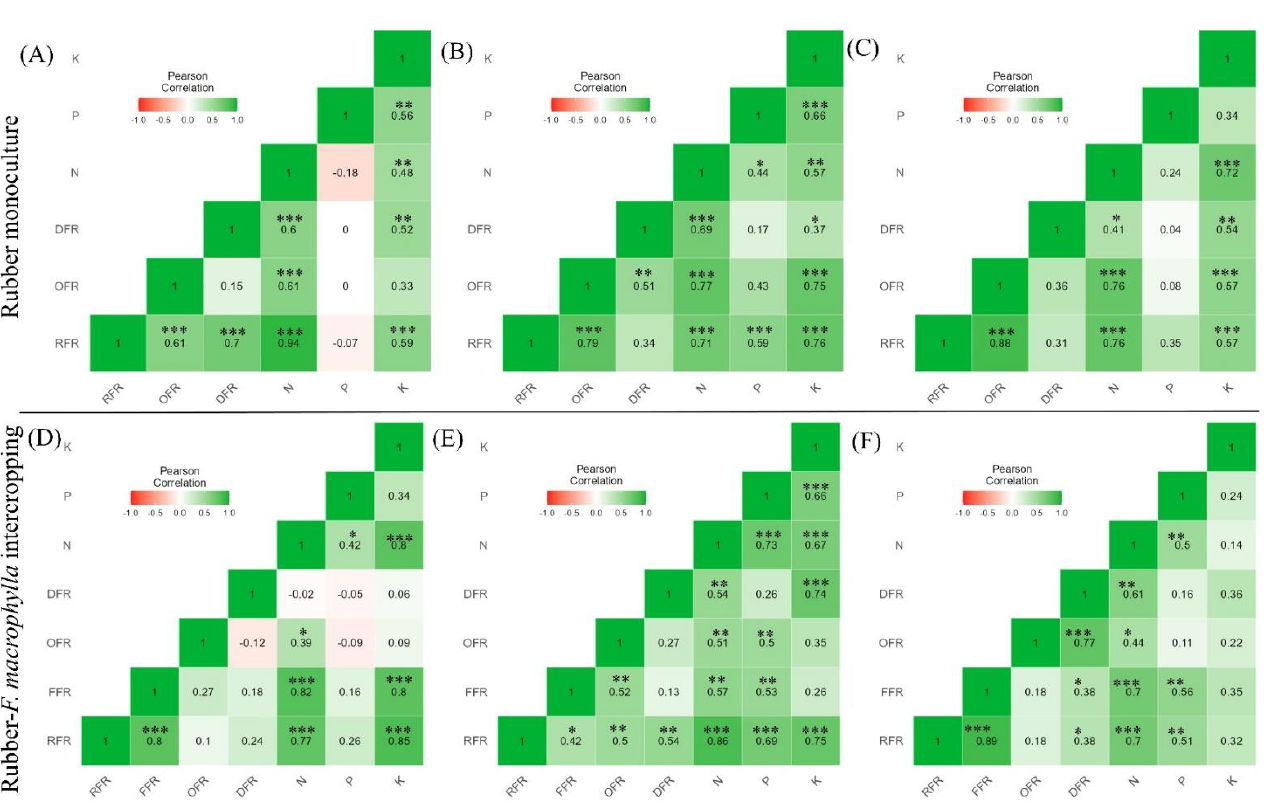
Figure 2. Correlational matrix of total fine root biomass with different species in rubber monoculture (( A ) = Correlogram of 12 years, ( B ) = Correlogram of 15 years, and ( C ) = Correlogram of 24 years) and rubber- F. macrophylla intercropping agroforestry system (( D ) = Correlogram of 12 years, ( E ) = Correlogram of 15 years, and ( F ) = Correlogram of 24 years). The acronyms represent fine roots of rubber (RFR), F. macrophylla (FFR), other (non-tress) (OFR), dead (DFR), and available nutrients (N, P, and K). The colored legend gradients represent correlation coefficients of r values from dark green (+1.0) to light red ( − 1.0). All coefficients were analyzed through the Pearson correlation at signifi- cance level: ***, p < .001; **, p < .01, *, p < 0.05 for the possible pair variables in the matrix.